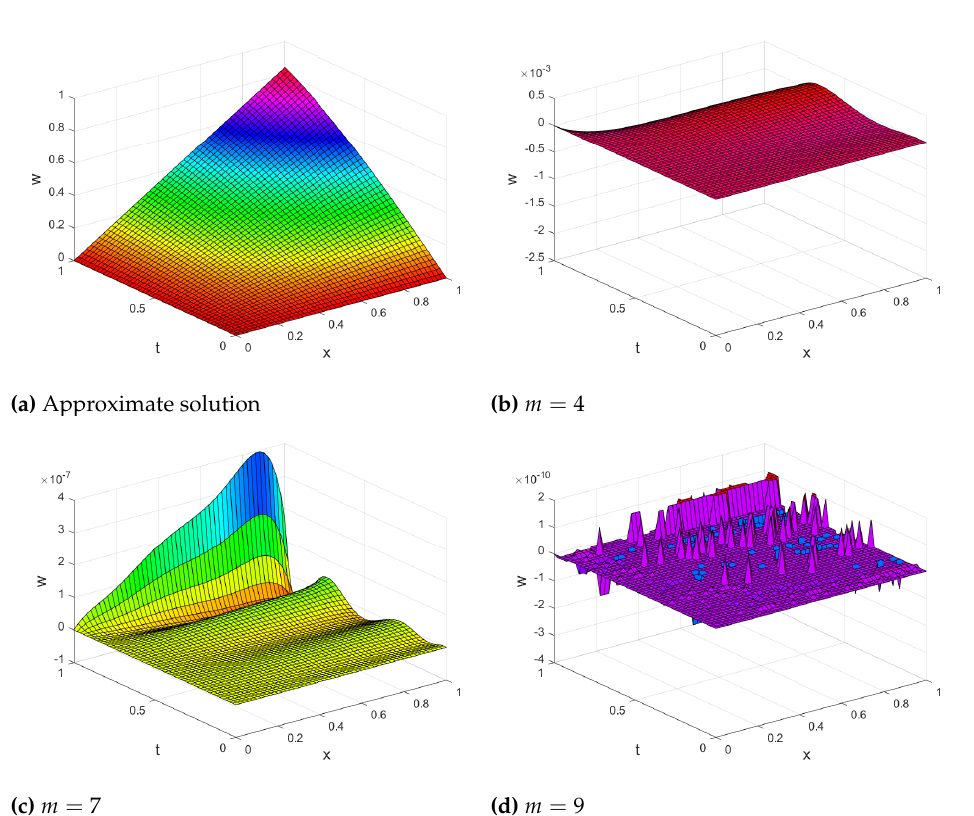
Figure 2. The approximate solution (top-left) and absolute errors by choosing different values of m for Example 2.